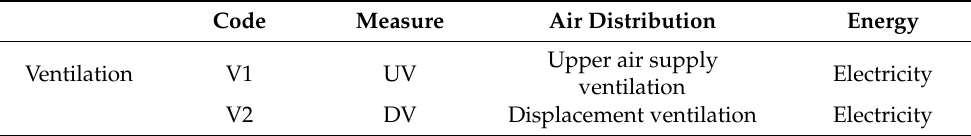
Table 2. Alternative ventilation measures for residential buildings in